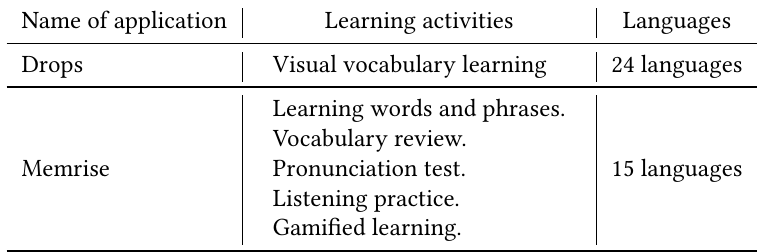
Table 1 Comparison of selected mobile language learning applications